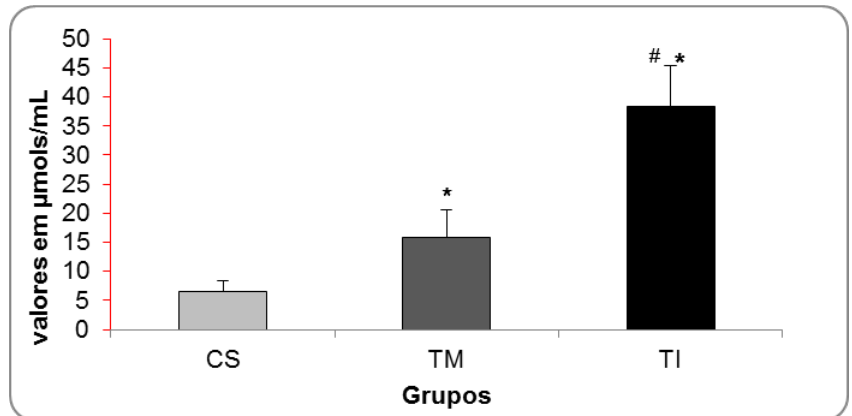
Figura 1. Produção de Óxido Nítrico por macrófagos alveolares após o TF. Dados em média e desvio padrão. ANOVA, post-hoc Turkey (p<0,001). * – Diferença entre grupos treinos e controle; # – Diferença entre grupos TM e